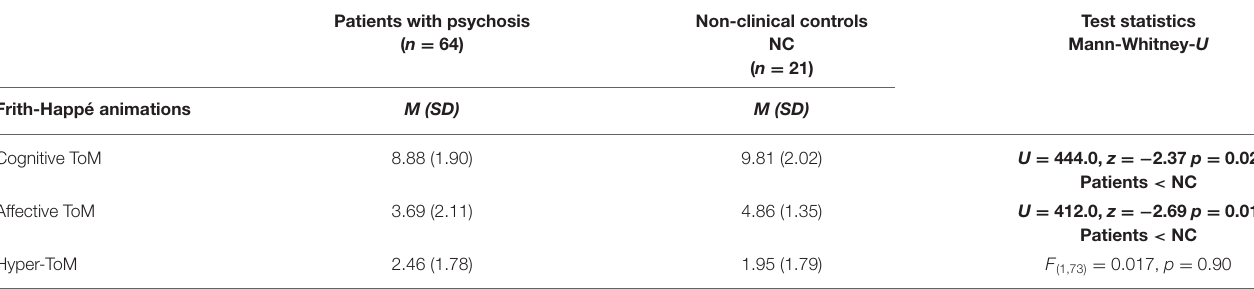
TABLE 2 | Comparisons between patients with psychosis and non-clinical controls in Cognitive ToM, Affective ToM, and Hyper-ToM errors.